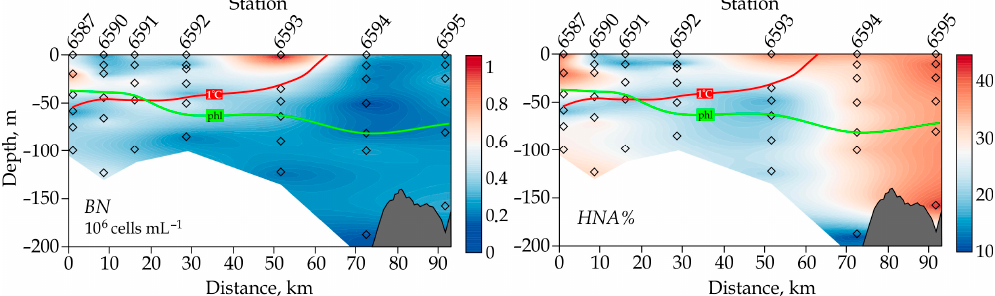
Figure 8. Vertical distribution of the total bacterioplankton ( BN ) and the fraction of HNA-bacteria ( HNA%) along the transect in the Bransfield Strait during austral mid-summer, January 2020. Green and red lines represent the bottom of the photic layer (phl) and 1°C isotherm (as a boundary between water masses), respectively.